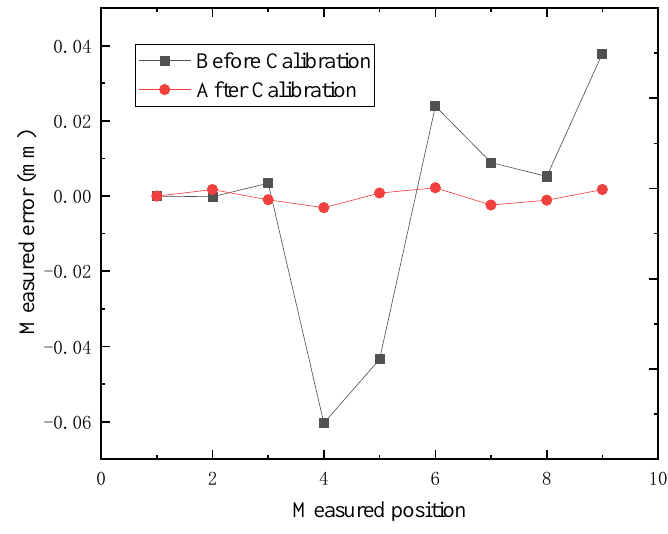
Figure 11. Comparison experiment.